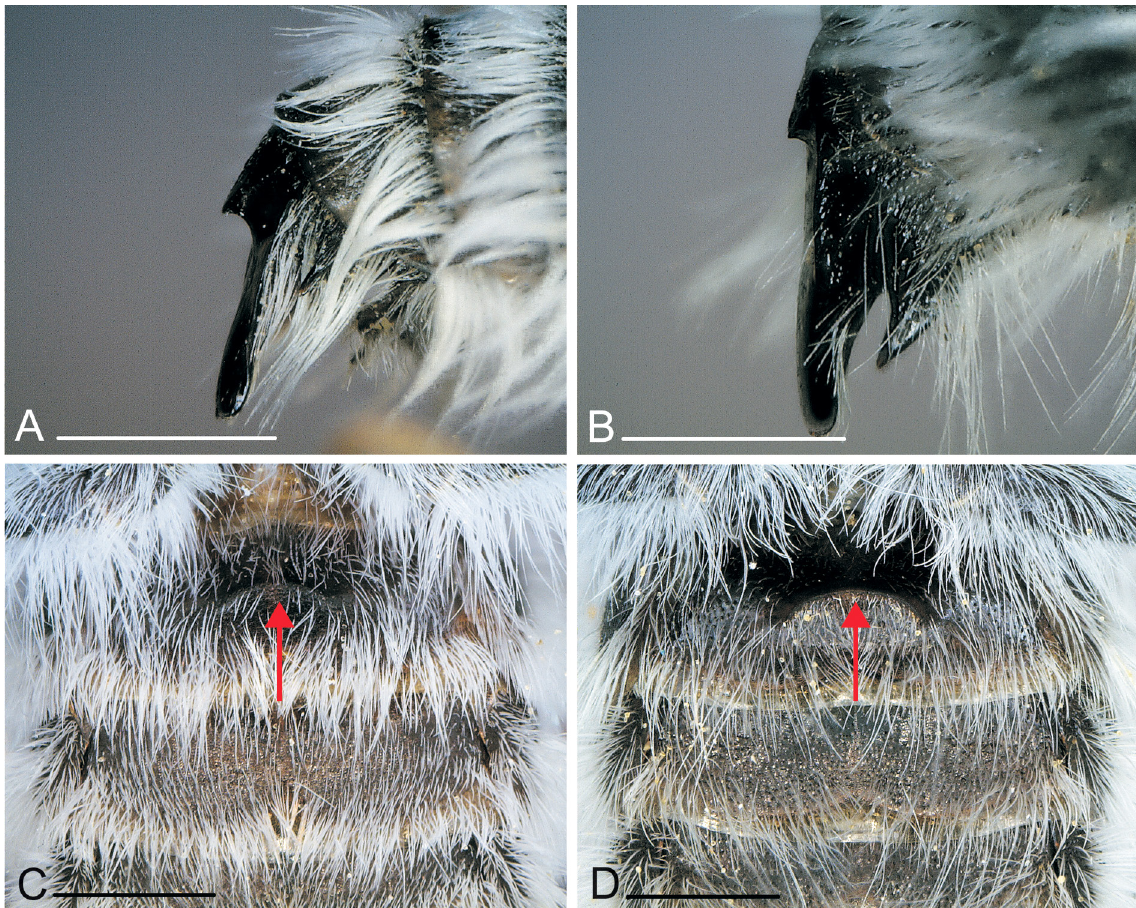
Fig. 2. Fidelia spp., ♂♂. A , C . Fidelia whiteheadi Litman & Kuhlmann sp. nov. (paratype). B , D . F. hessei Whitehead & Eardley, 2003. A – B . Protuberance at base of T7. C – D . Protuberance on S2, indicated by red arrow. Scale bars: 1